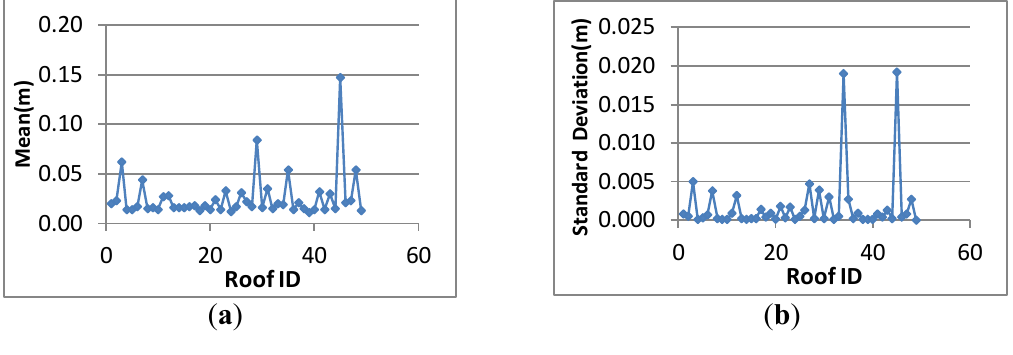
Figure 15. Plane fitting result in the test area. ( a ) The mean distances (in meters) of the points to the corresponding roof surface; ( b ) The standard deviation of the distances (in meters) of points to the corresponding roof surface.